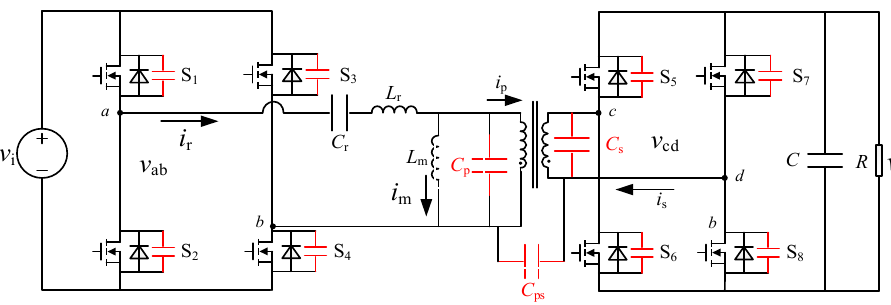
Figure 1. LLC resonant converter circuit considering the parasitic capacitance.